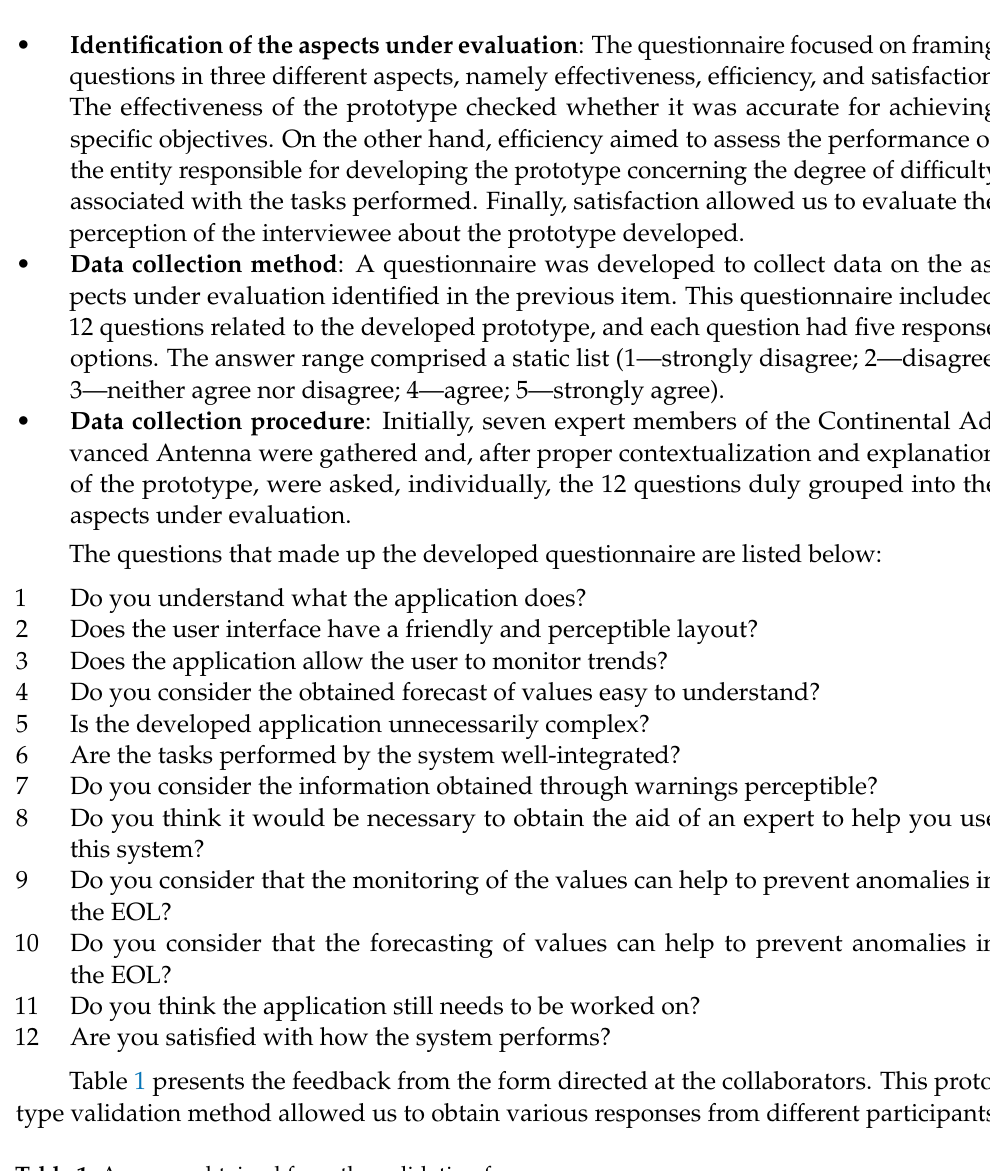
Table 1. Answers obtained from the validation